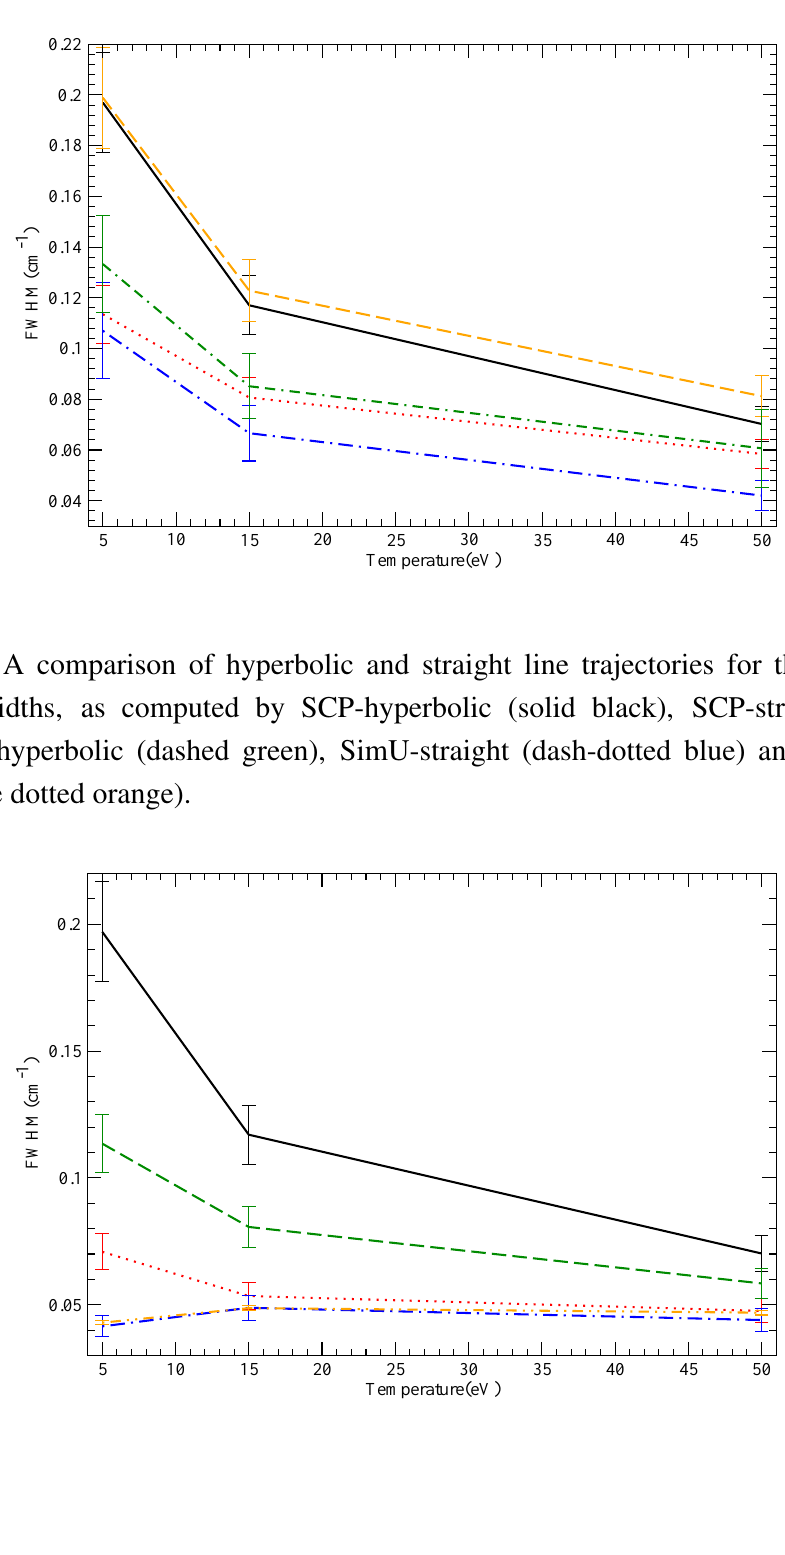
Figure 4. A comparison of hyperbolic trajectory NV 2s-2p transition widths, as computed by SCP (solid black), SimU (dotted red), DARC (dashed green) and Starcode with (dash-dotted blue) and without (dot-double dash orange) penetration accounted for.